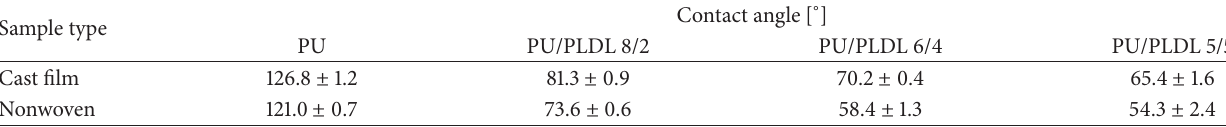
Table 1: Measurement results of initial contact angle of cast films and nonwovens obtained from pure PU and different PU/PLDL